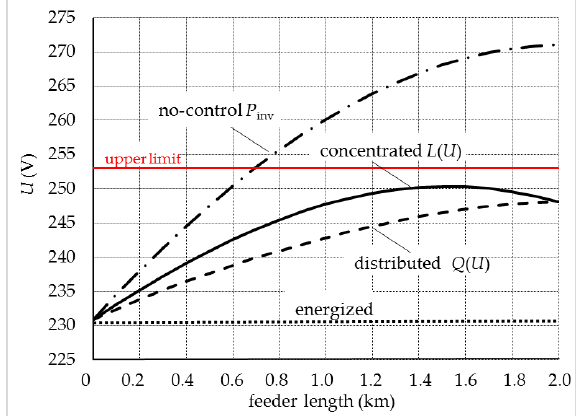
Figure 13. Voltage profiles for different control strategies: No control (inverters inject with cos( ϕ ) = 1), distributed Q ( U ) and concentrated L ( U ) control.